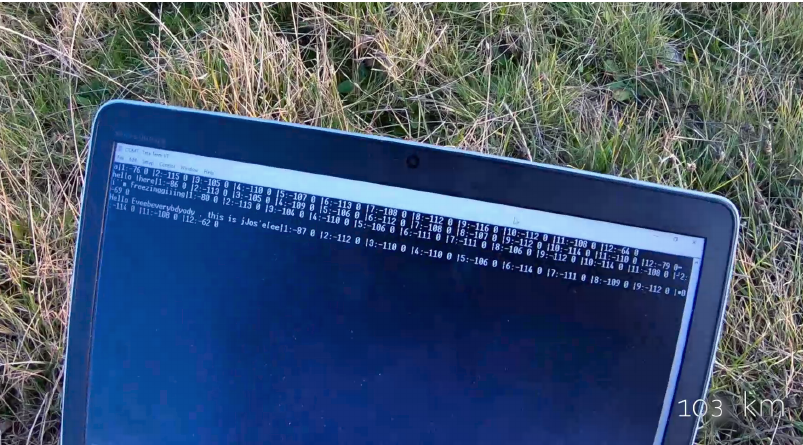
Figure 12. Captured packets 103 km away from the transmitting computer.